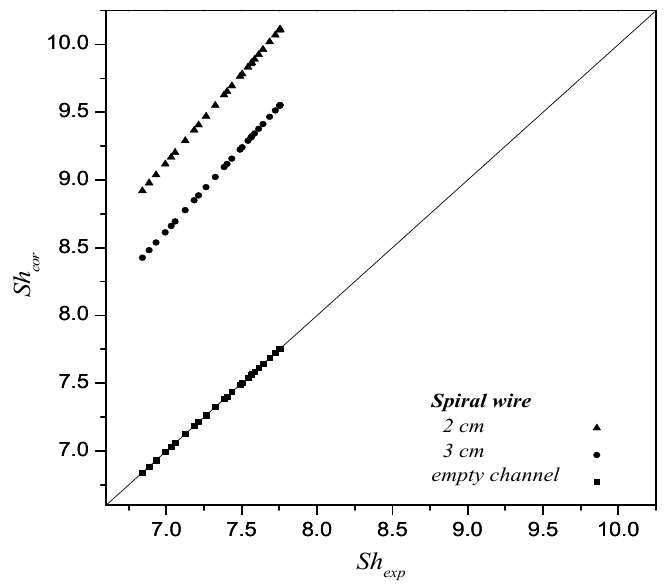
Figure 7. Comparison of correlated and experimental Sherwood numbers for the empty channel and spiral wired annulus channel with various spiral-wire pitches.